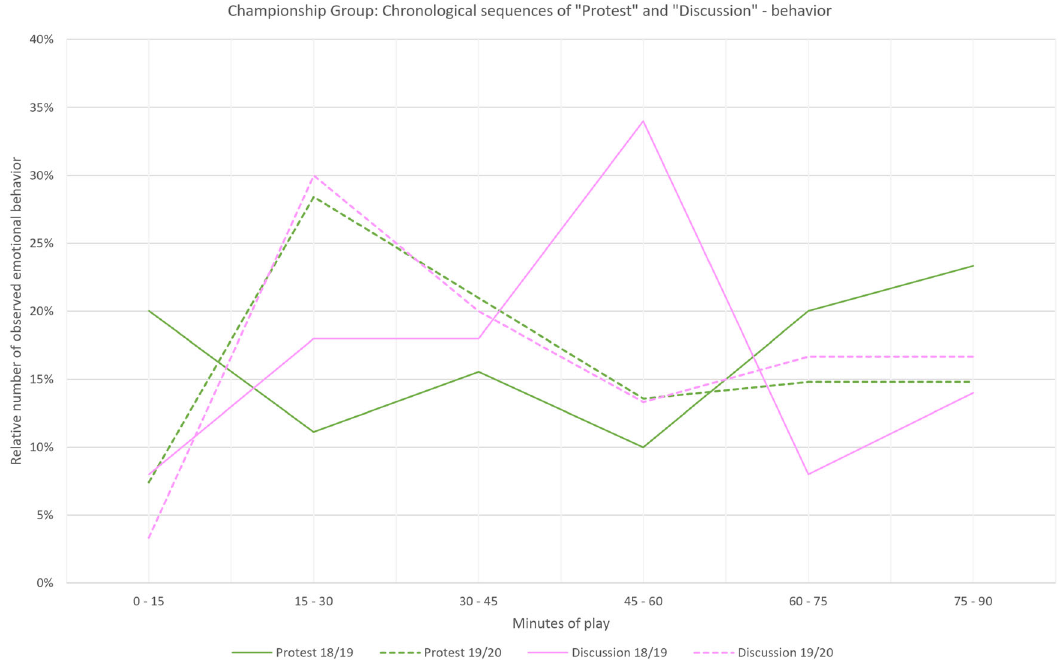
Fig. 7 Chronological sequences of “ Protest ” and “ Discussion ” . Chronological development of relative numbers of players (and staff) displaying “ Protest ” in matches of FC Red Bull Salzburg (RBS) during the championship group phase in both seasons of 2018/19 (continuous green line) and 2019/20 (dotted green line). Graphical distribution illustrates a noticeable accumulation of “ Protest ” in “ ghost games ” in the mid of the fi rst half, which declines during the rest of the match. Contrarily, another noticeable accumulation of “ Protest ” in regular games of season 18/19 can be found towards the end of matches. Regarding “ Discussion ” during the championship group phase in both seasons of 2018/19 (continuous pink line) and 2019/20 (dotted pink line) graphical distribution illustrates a noticeable accumulation of “ Discussion ” in “ ghost games ” in the mid of the fi rst half, and a second noticeable accumulation of “ Discussion ” in regular games in the early phases of the second half. This double peak formation indicates a chronological shift in players and staff behavior in “ ghost games ”